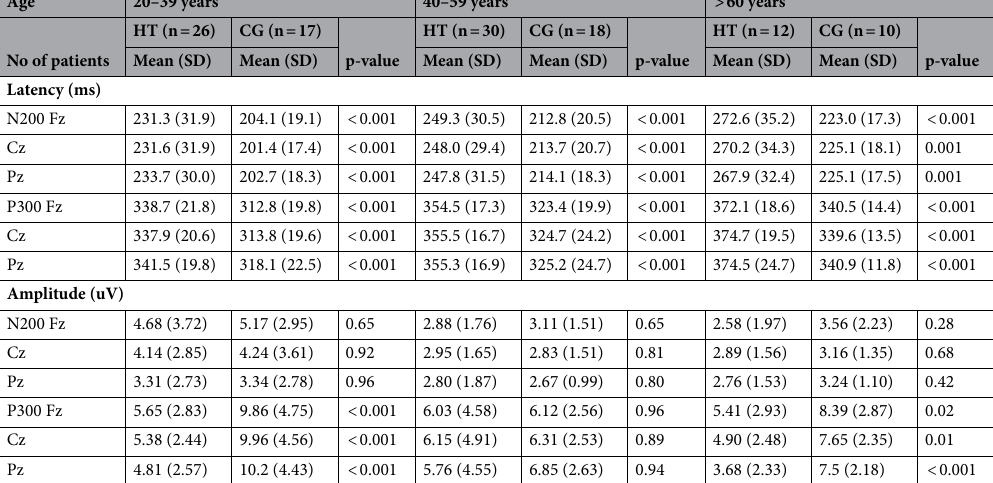
Table 3. Mean values and standard deviations (SD) of N200 and P300 parameters in HT patients depending on their age. CG control group, HT Hashimoto’s thyroiditis, SD standard deviation, Fz frontal region, Cz central region, Pz parietal